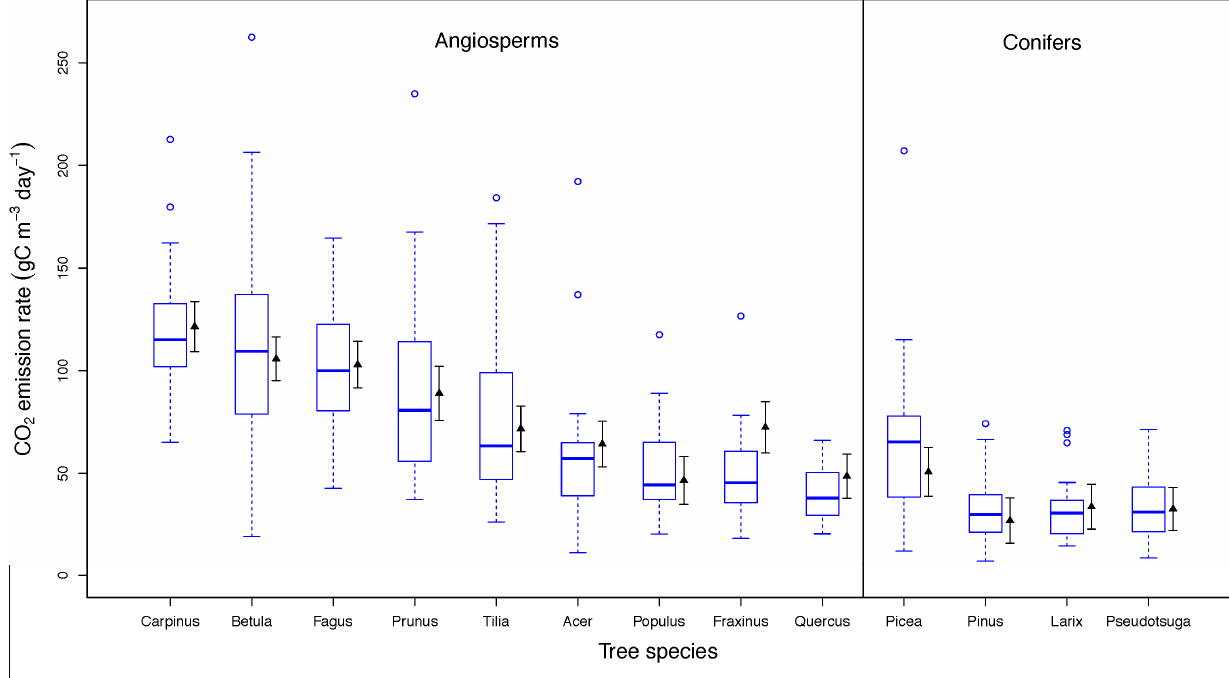
Figure 2. Relationship between CO 2 emission rates and the significant explanatory variable dead wood tree species for the best-fit global model. Triangles with lines represent the mean effect size and 95% confidence interval for each tree species corrected for the influence of the other variables in the best-fit global model. The blue boxplots represent field observations from 355